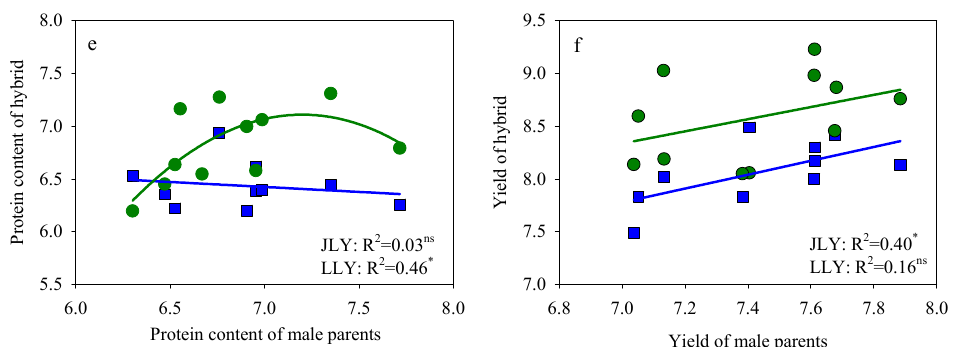
Figure 3. Correlations of chalkiness degree ( a ), alkali spreading value ( b ), amylose content ( c ), gel consistency ( d ), protein content ( e ) and yield ( f ) between hybrids and their male parents in 2020. ns: non significance; *, **, and *** represent significance at p < 0.1, p < 0.05, and p < 0.01, respectively. LLY (the green circle) and JLY (the blue square) represent hybrids derived from Longke638S and Jing4155S, respectively.